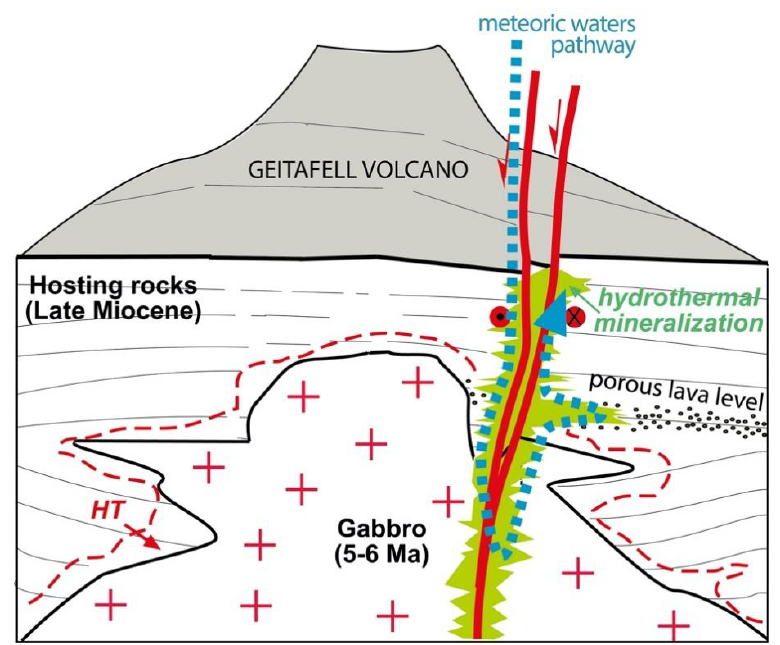
Figure 17. Conceptual model illustrating the relationships among fractures, meteoric fluid pathways and hydrothermal mineralization at the Geitafell study area (after Reference [13]).